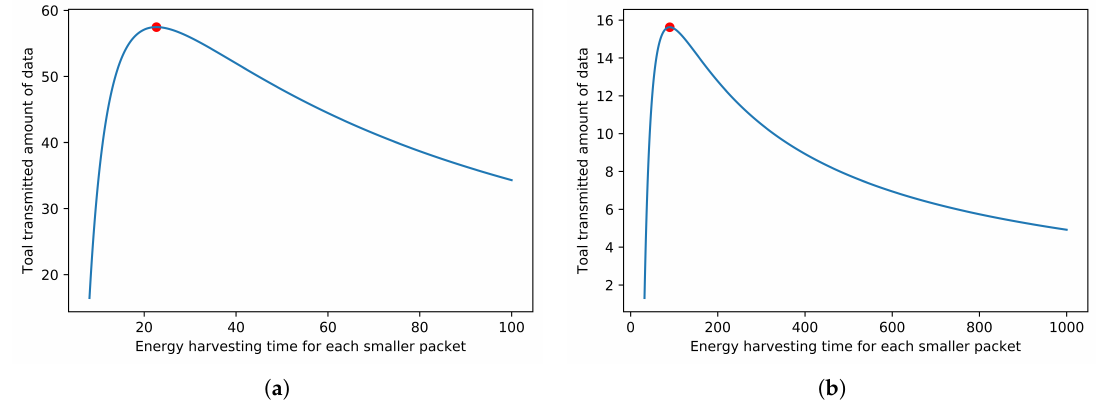
Figure 8. Find the maximum amount of transmitted data. ( a ) header=3; ( b )